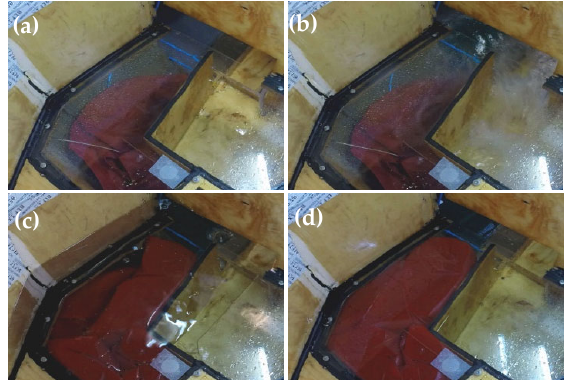
Figure A5. The red inflatable container for displacement of floodwater in compartment T045: ( a ) empty container in the empty compartment, ( b ) water rushes into the compartments, ( c ) the container being filled with pressurized air floats on the floodwater, ( d ) the fully inflated container has displaced most of the floodwater in the compartment.